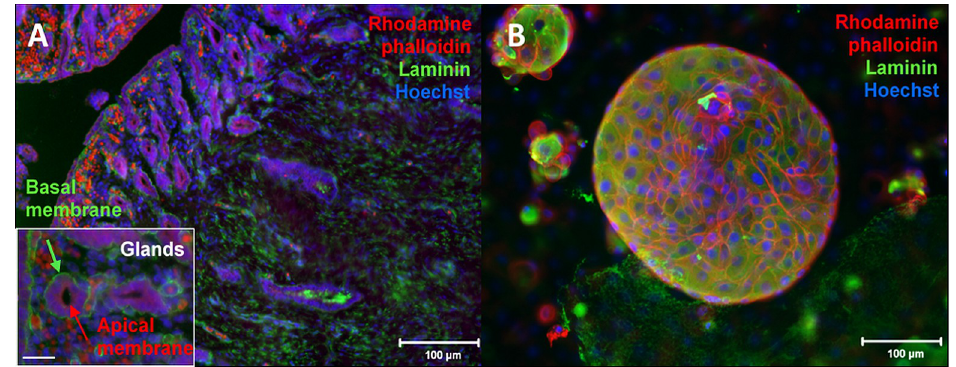
Fig 3. Immunostaining for cell polarity. Fluorescent micrograph of immunostaining with Rhodamine phalloidin (cytoskeleton = red), laminin (basement membrane = green), and Hoechst (nuclei = blue) (A) 5 μ m uterine horn cross-section. Inset: 400X micrograph of two individual glandular structures which show apico-basal polarity where the laminin-rich basement membrane faces away from the lumen. Bar = 50 μ m (B) Circular cell structure stained after two weeks of endometrial cell